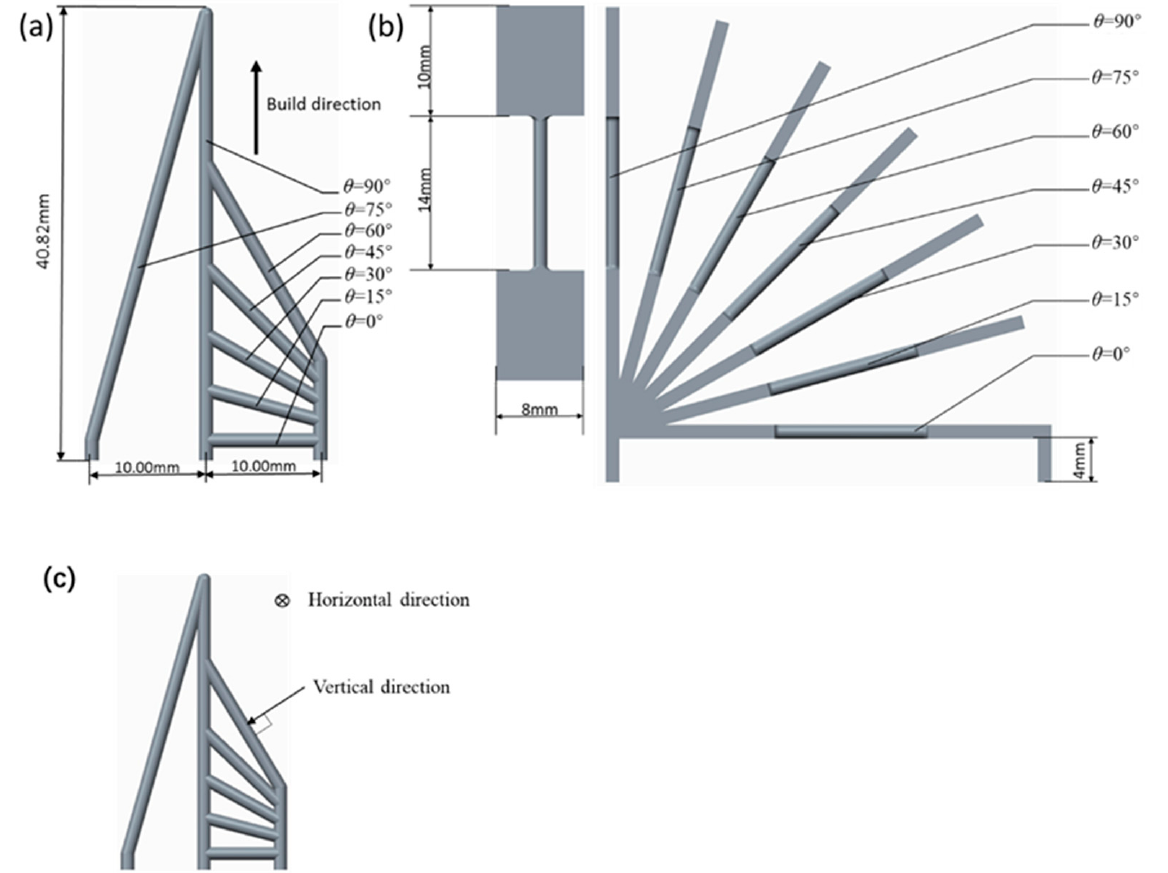
Figure 1. Detail of the sample structure: ( a ) RA sample used for SEM observing; ( b ) RB sample used for tensile test; and ( c ) the view of horizontal direction and vertical direction.